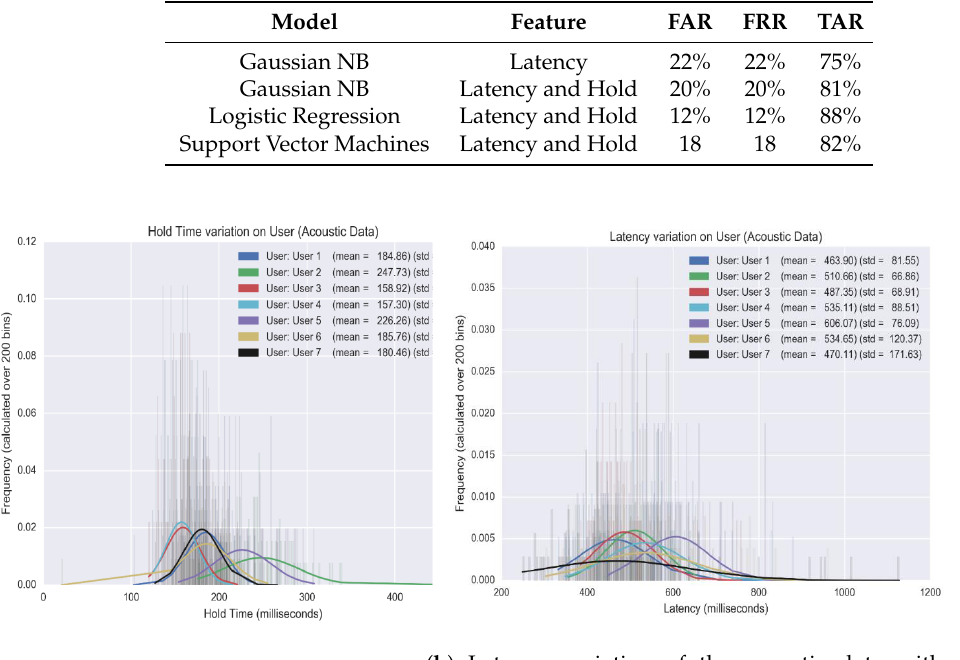
Figure 17. Hold and Latency variation with different